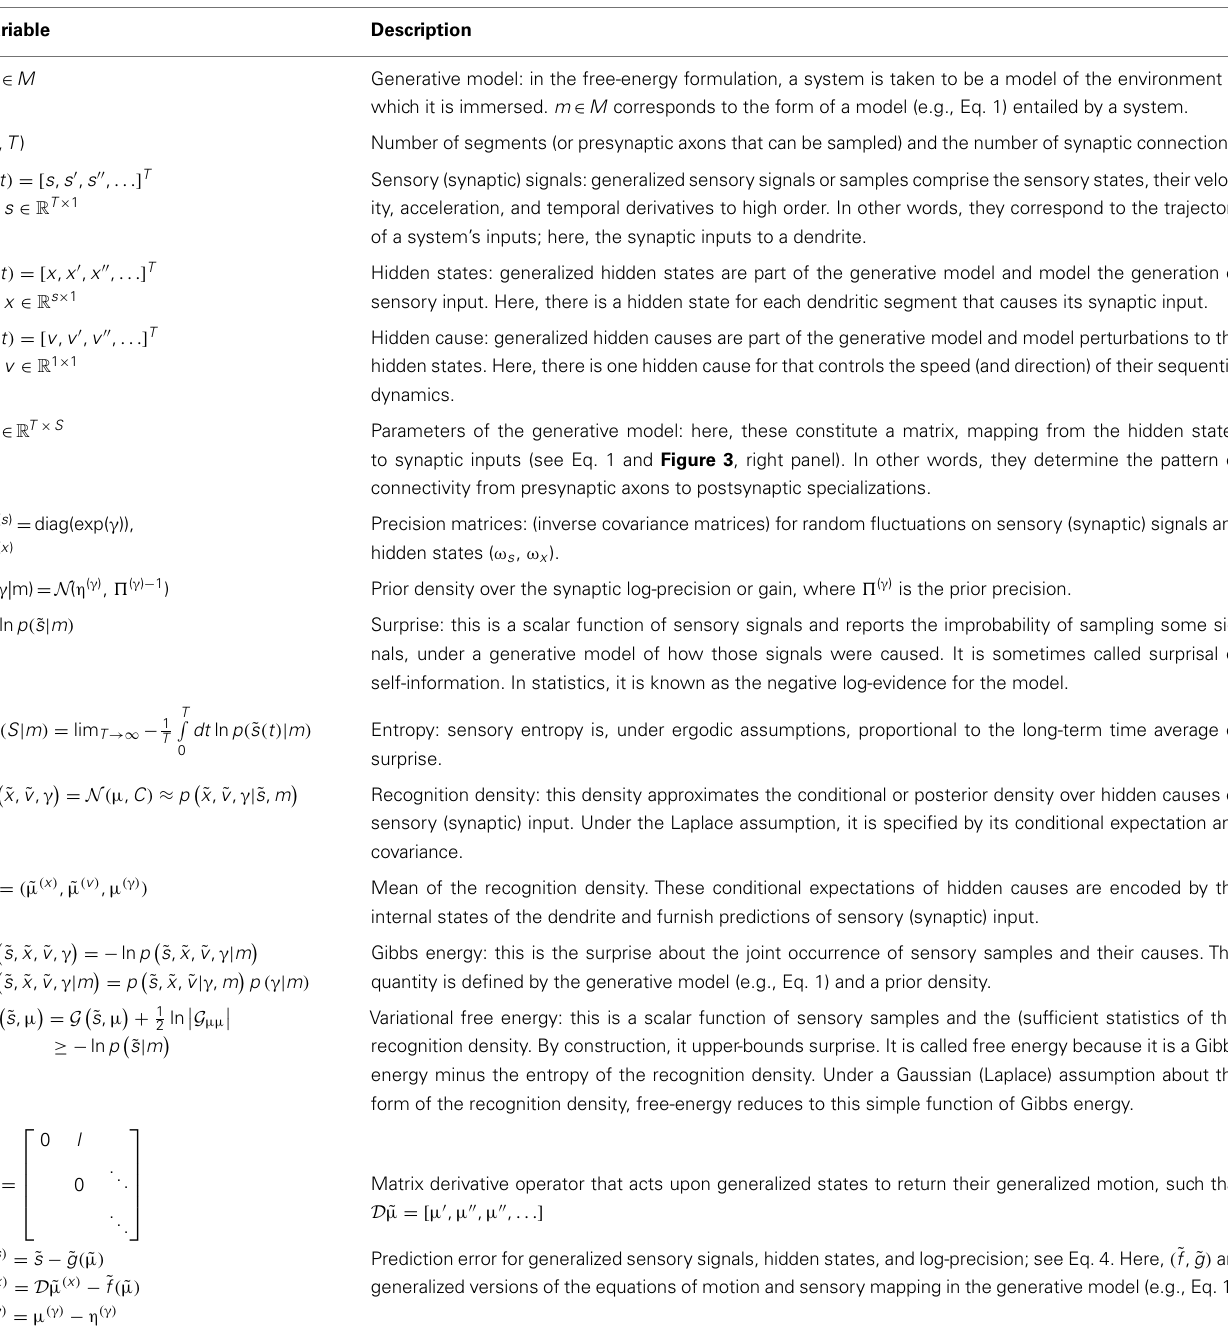
Table 1 | Key quantities in the free-energy formulation of dendritic sampling and reorganization. Variable